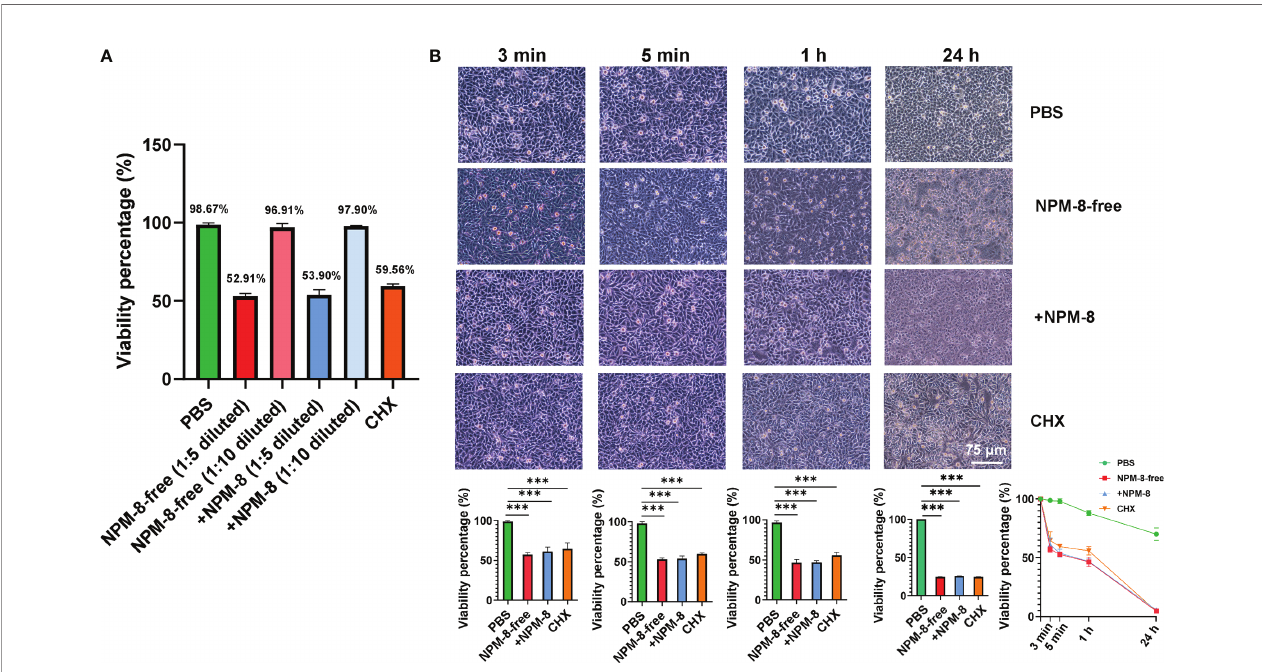
FIGURE 4 | Cytotoxicity of the four test agents on HGE cells. (A) Viability of the HGE cells exposed to PBS, 1:5- or 1:10-diluted toothpastes, and CHX treatment. (B) Representative images of HGE cells after stimulation with the four test agents (PBS, 1:5 diluted toothpastes, and CHX) for 3 min, 5 min, 1 h and 24 h. The HGE cells viability was quanti fi ed. Data are presented as means ± SD. *** P < 0.001.